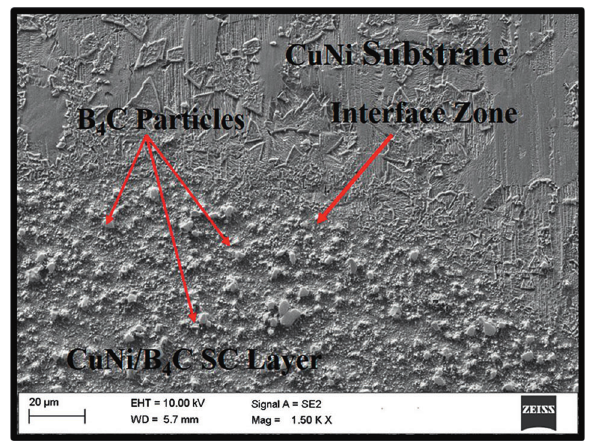
Figure 13: FESEM micrograph showing good interfacial bonding between parent metal and carbide particulates in the stir region.